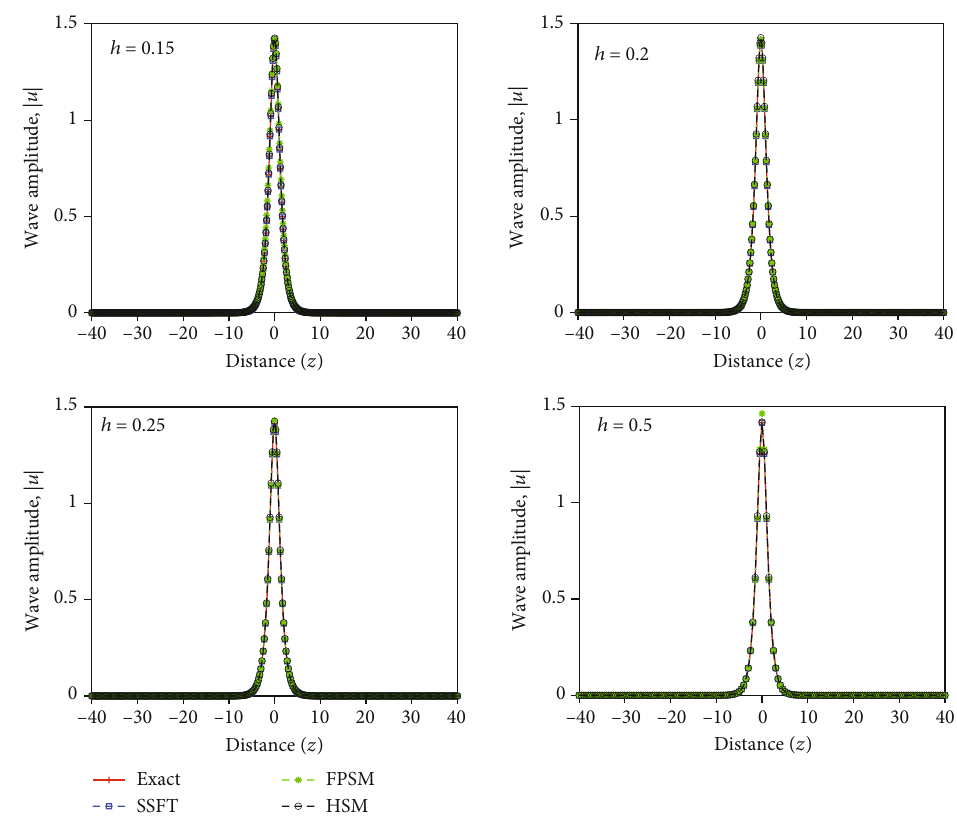
Figure 3: A comparison of the split-step Fourier transform (SSFT), the Fourier pseudospectral method (FPSM), the Hopscotch method (HSM), and the exact solution at τ = 0 : 001 and t = 20 over a space domain z from -40 to 40, whereas using di ff erent values of h